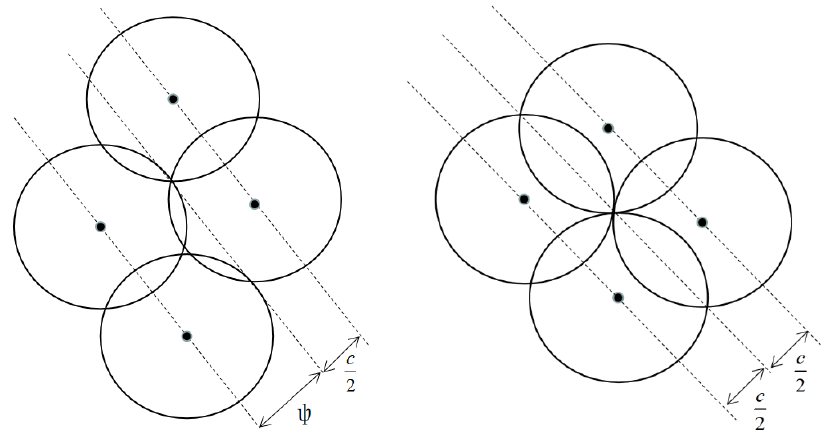
where j is the number of multiple coverages, and j ≤ S − 1 and S are the total number of satellites in the same orbital plane. For multiple coverage zones composed of multiple satellites, the coverage area is reduced accordingly. For the coverage belt composed of P orbital planes, the width of the coverage belt can be widened or narrowed by adjusting the RAAN between the adjacent orbital planes. Assuming that the satellites on the two orbital planes move in the same direction, the width of the coverage zone is expressed as: In the design of SOC, the motion direction of satellites in adjacent orbits is the same, and the motion direction of the first orbital plane and the last orbital plane is opposite, as shown in the Figure 3: